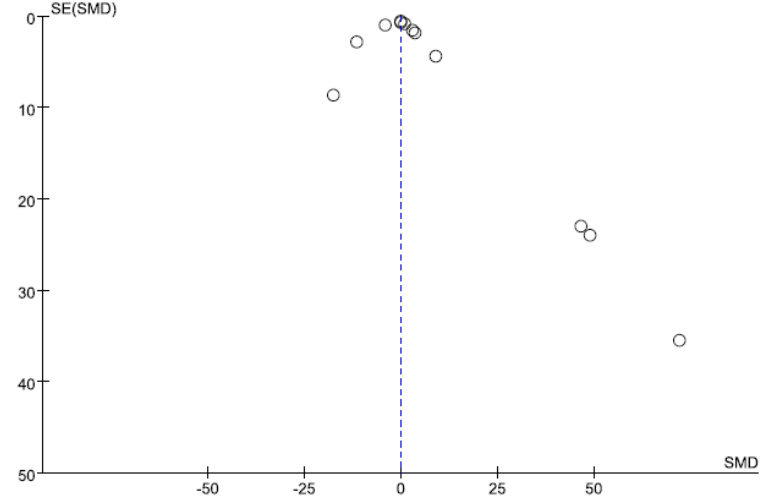
Figure 12. Funnel plot for NF ‐κ B. The blue ‐ dotted line shows the overall estimated standard mean difference. Evidence for publication bias was not found ( p = 0.441). Abbreviations: SMD = standard mean difference, SE = standard error.